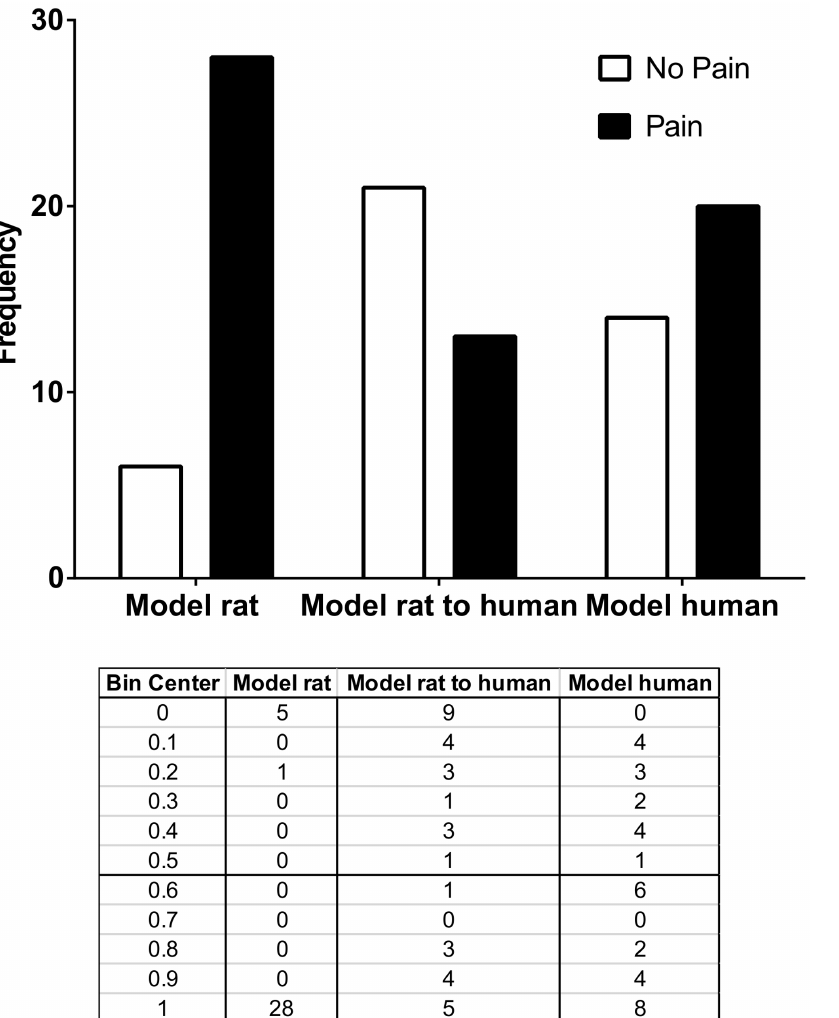
Figure 8. Representation of the constructed models Model rat, Model rat to human and Model human that predicted the presence of pain in the expanded cohort. Bin center 0 represents no pain and 1 represents